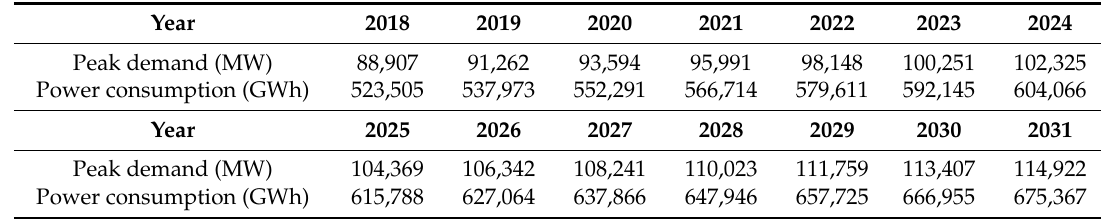
Table 1. Target Demand Outlook DR by the 8th BPE.